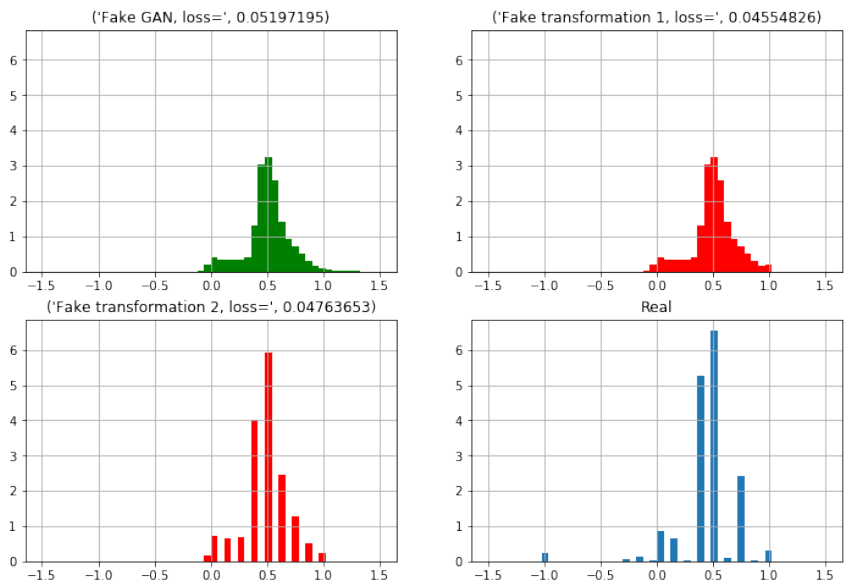
Figure 10. Distribution of the ‘Recoded_Clinical_Stage’ feature from the raw GAN-generated synthetic data (upper left), after the first (upper right) and the second transformation (lower left) and that from the real patients (lower right).